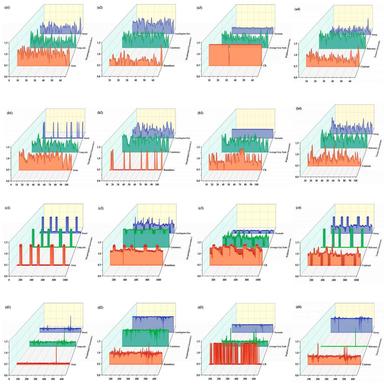
Characteristic diagrams of different flame types. (a) Unstable; (b) Stable; (c) Tempering; (d) Diffusion; (1) Morphological characteristics 1; (2) Morphological characteristics 2; (3) Brightness characteristics; (4) Textural characteristics.